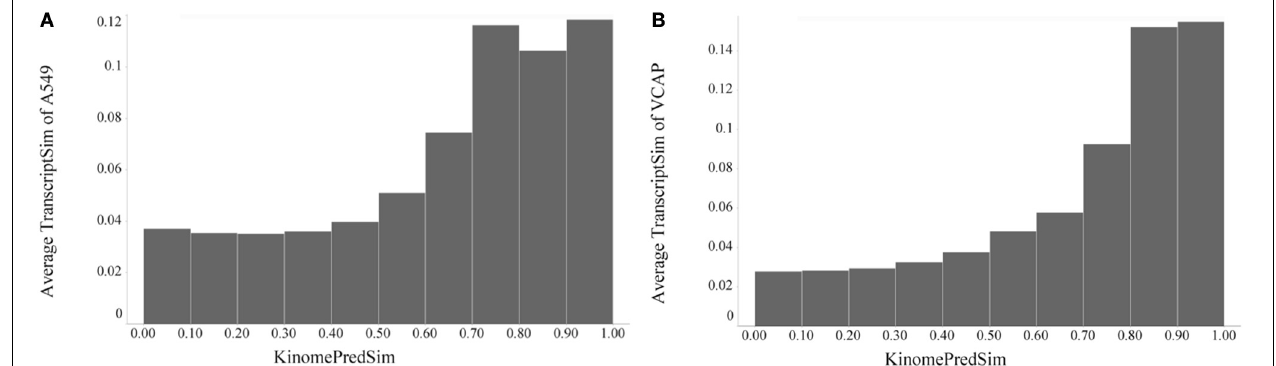
FIGURE 9 | Globaltrendofpairwisetranscriptionalsimilarity(TranscriptSim)in(A)A549cellsand(B)VCAPcellsasafunctionofpredictedkinaseprofile similarity(KinomePredSim)for1027and741compoundspercellline,respectively,illustratedasaverageTranscriptSimvaluesbyKinomePredSimranges.